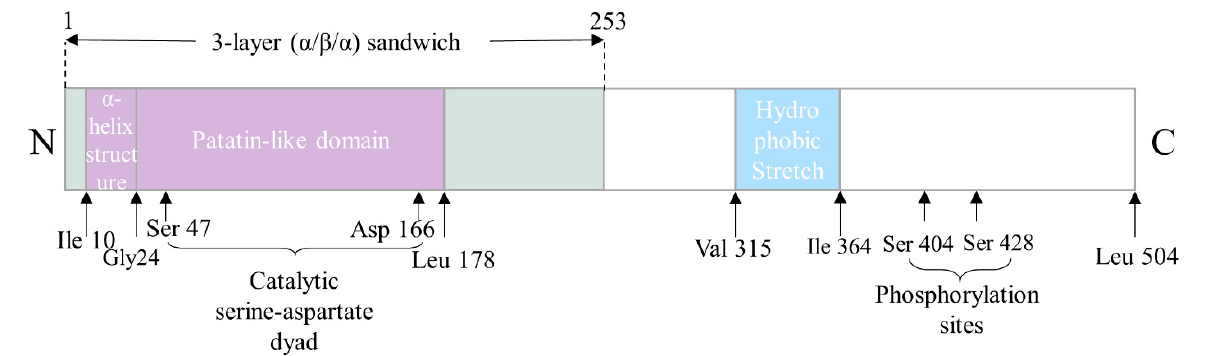
Figure 1. Schematic representation of predicted structure and domain organizations of hATGL. Green: three-layer ( α / β / α ) sandwich domain (residue 1–253). Purple: Patatin-like domain (residue 10–178), including the α -helix structure (residue 10–24) and the catalytic serine-aspartate dyad (Ser 47 and Asp 166), which are essential in TG substrate binding and TG hydrolysis, respectively. Blue: putative hydrophobic lipid-binding stretch (residue 315–364), and two potential AMPK phosphorylation sites (Ser 404 and Ser 428), which are responsible for the localization of ATGL on LDs.